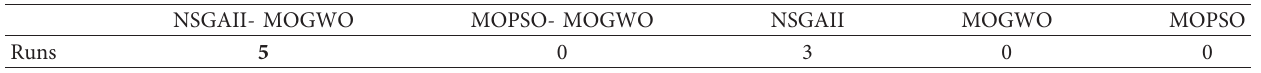
Table 16: Runs of the optimal solution on relative fairness objective in ten independent runs.